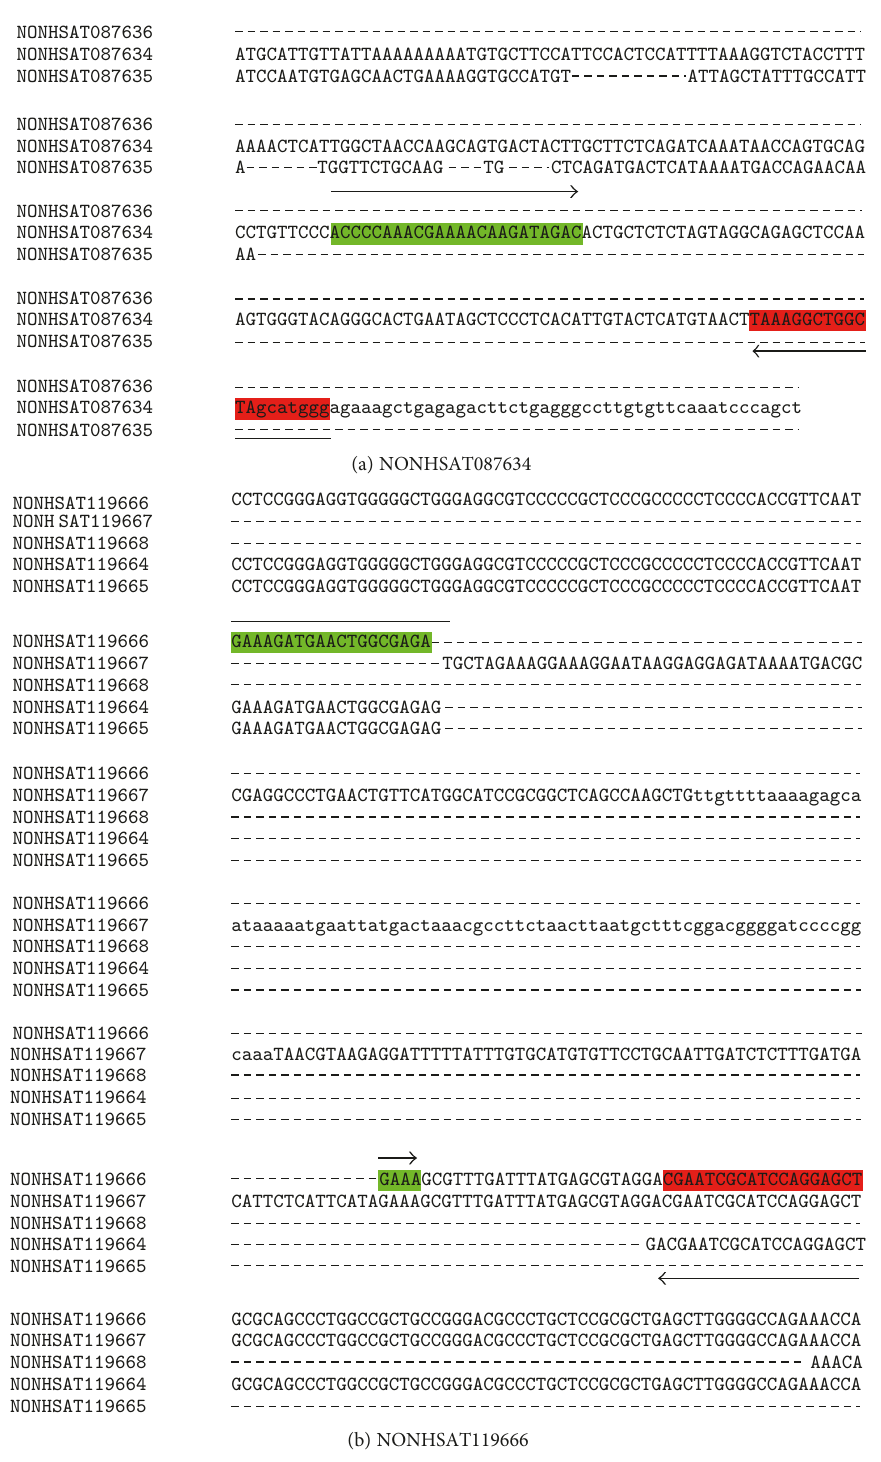
Figure 1: Schematic of (a) NONHSAT087634 and (b) NONHSAT119666 splice variant speci fi c primer